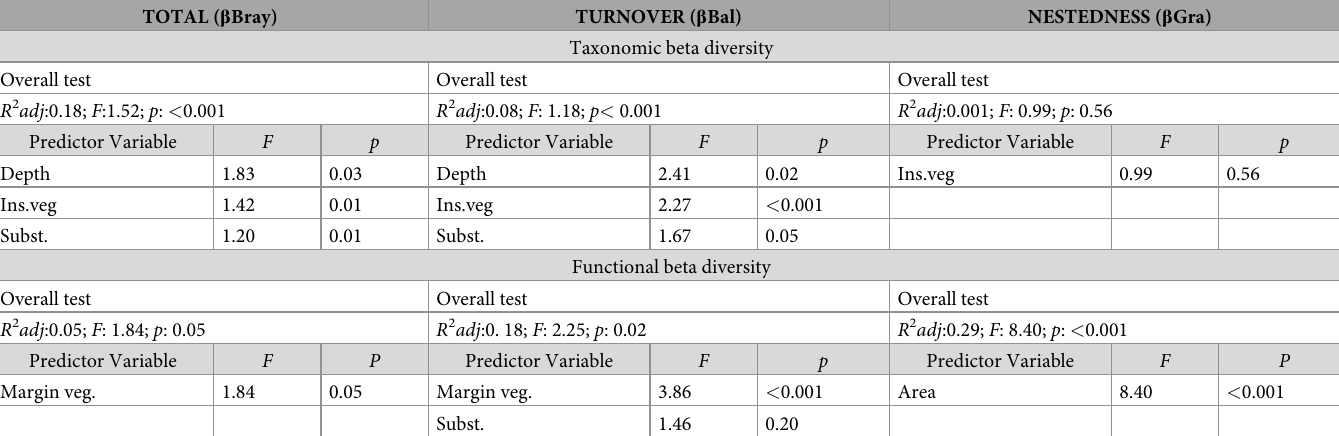
Table 2. Results of distance-based RDAs for the abundance data. Analyses were run for taxonomic and functional components based on total beta diversity, turnover and nestedness dissimilarities. Full models and marginal tests of significance for single environmental variables are shown (i.e., separate significance test for each variable in a model when all other terms are in the